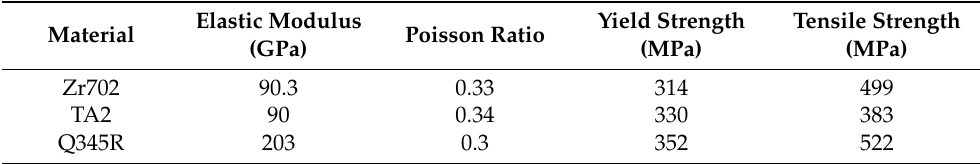
Table 1. Comparison of mechanical properties of Zr702, TA2 and Q345R.